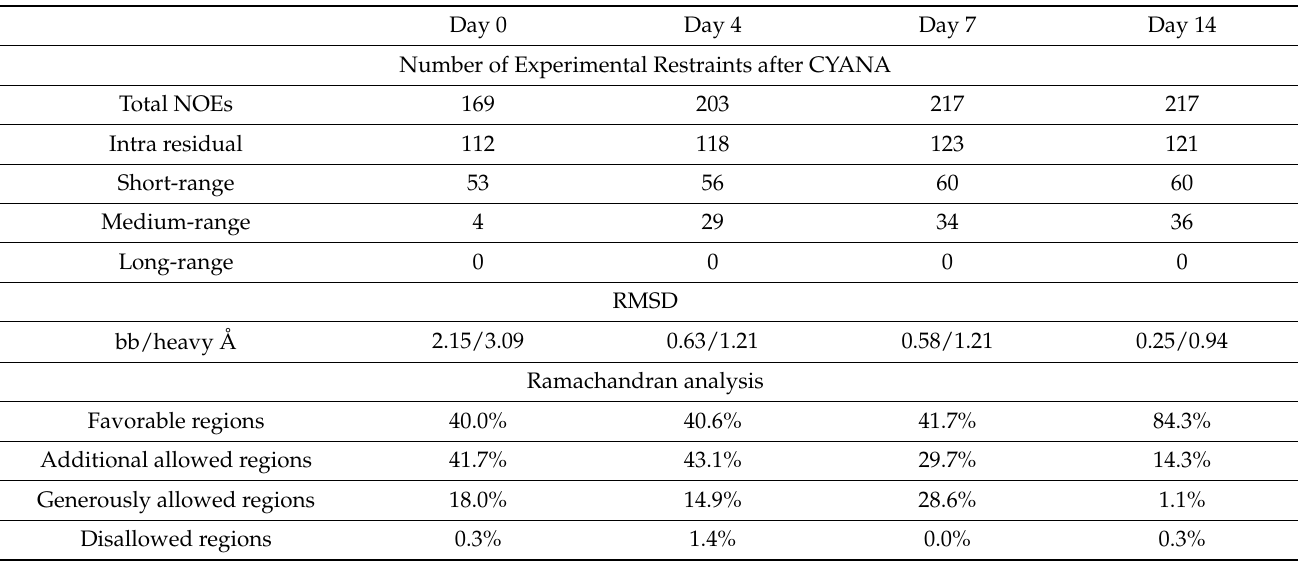
Table 2. Statistics for the structural calculation of the NMR ensemble of A β (25 − 35) peptide at 0, 4, 7, and 14 days in SDS